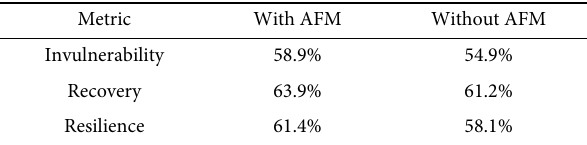
b c 1 Fig. 12 Federated learning results. ( a ) Difference of and between two consecutive rounds of training. ( b ) Training finish sequence for the six neural networks. microgrid 2, and microgrid 3’s three phases, respectively. The x - axis is for currents’ real parts and the y -axis is for imaginary parts. where is the resilience. is the invulnerability and is the recovery. is the value of the variable of interest during disturbance and is the variable’s values before disturbance. and are the disturbance happening time and clearing time, respectively. , , and are all in the range of 0 to 1. Larger means the system is more resilient. Table 2 and Table 3 show resilience metrics for is a microgrid’s rated voltages and current contributions, respectively. Values in the value. Root mean square (RMS) errors for microgrid 1’s three table are calculated based on Figure 16. The resilience metrics for phases in Figure 13 are 4.3%, 4.5%, and 3.0%. RMS errors for current contributions are calculated using the worst current con- microgrid 2’s three phases in Figure 14 are 10.9%, 9.9% and 8.8%. tributions, 54.4 A, as a base. Table 2 Resilience metrics for microgrid voltages